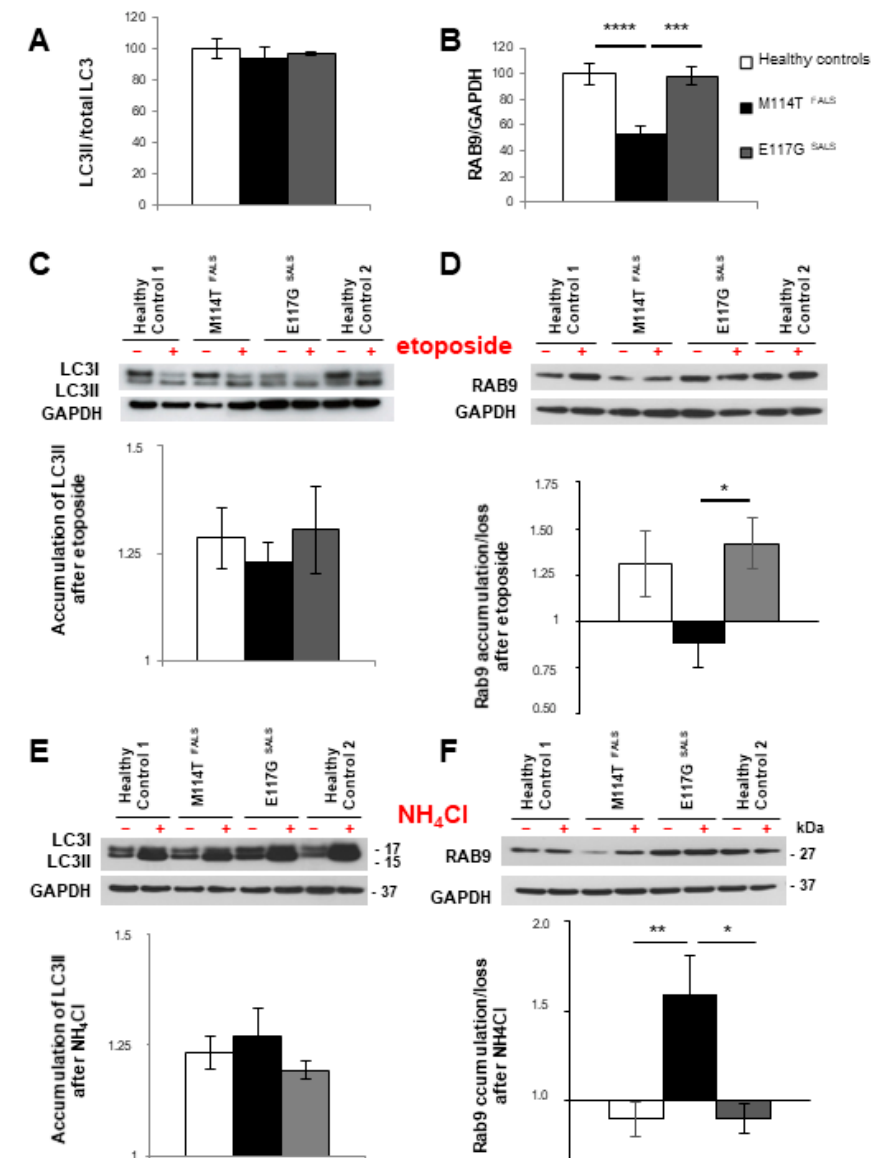
Figure 2. Deregulation of macroautophagy in M114T lymphoblasts. ( A – F ) Immunoblot analysis of protein extracts from lymphoblasts of healthy controls (white) and ALS patients carrying the M114T (black) and E117G (grey) PFN1 mutations. ( A ) Densitometry analyses show the amount of LC3II to total LC3 or (B) RAB9 levels standardized to GAPDH expression. Protein levels are represented as a percentage of the healthy controls. ( C , D ) Patient lymphoblasts were treated (+) or not ( − ) with etoposide autophagy inducer or ( E , F ) NH 4 Cl lysosomal inhibitor. (C, E, lower panel) Accumulation of LC3II and (D, F, lower panels) RAB9 after these treatments were evaluated by densitometry and presented as fold of induction. Results are means ± SEM for 3 to 8 independent experiments. * p <